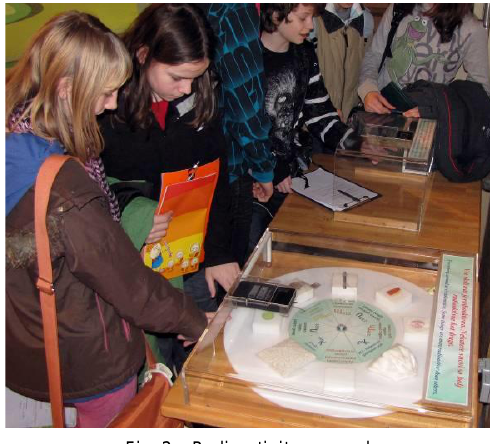
Fig. 2. Radioactivity carousel.